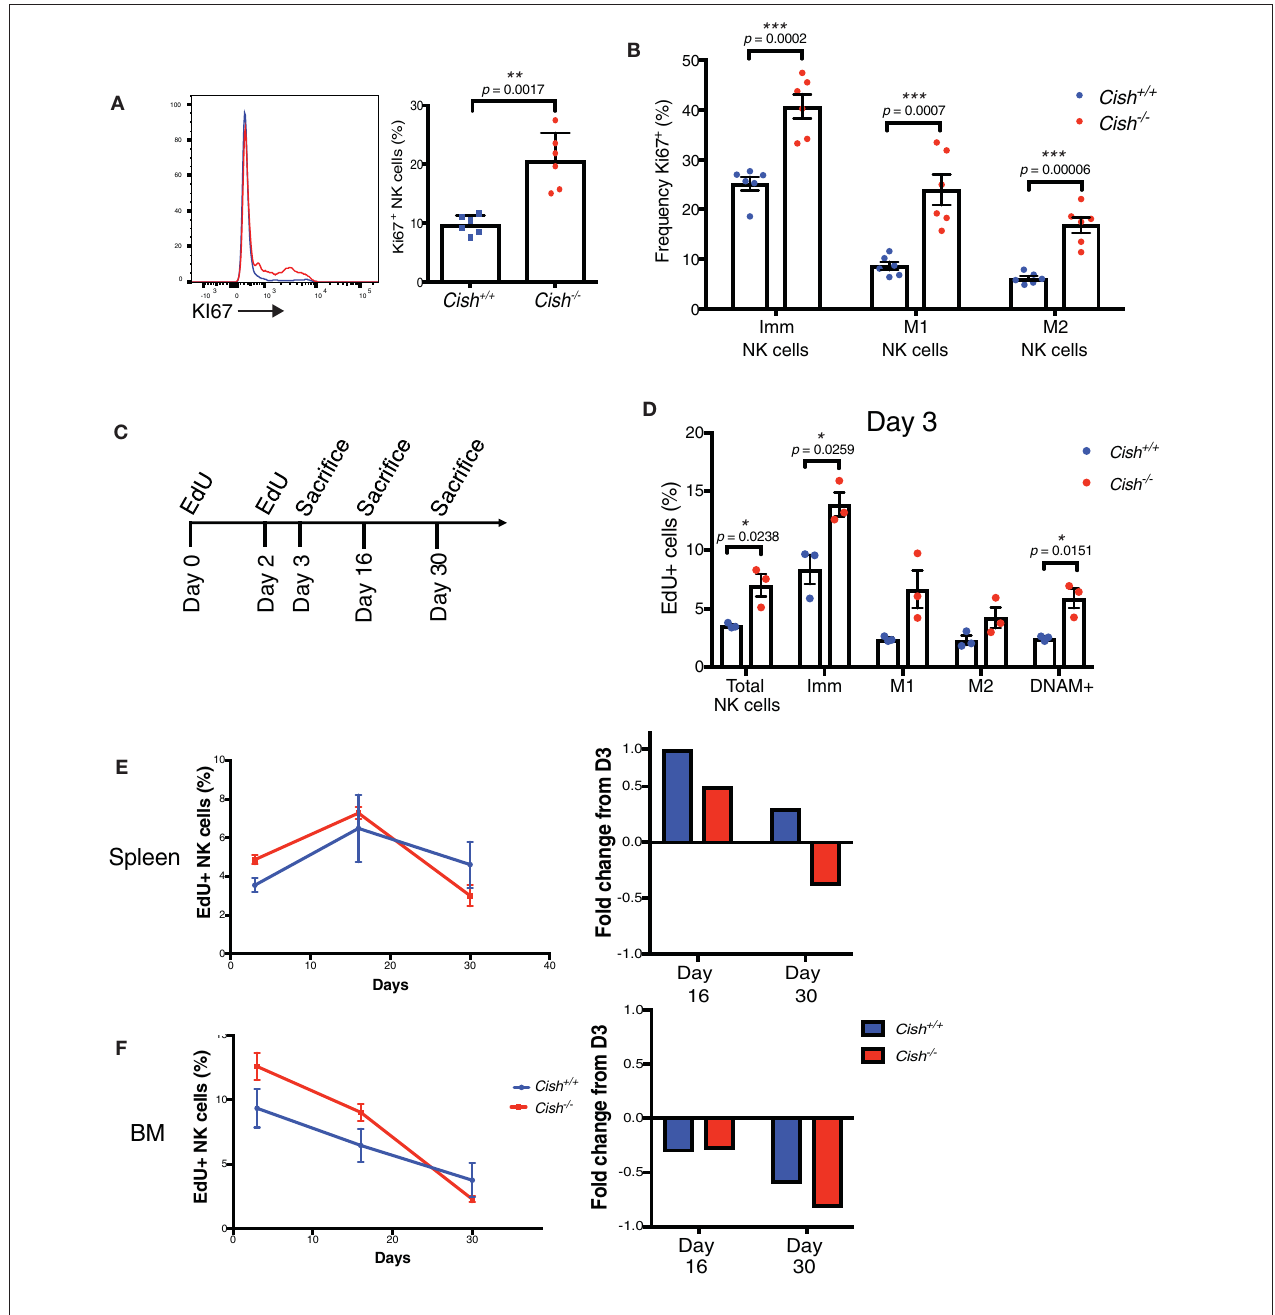
FIGURE 2 | CIS governs NK cell turnover but not accumulation in vivo. (A) Splenic NK cells from 6 to 8 week-old Cish + / + and Cish − / − mice were phenotypically analyzed by flow cytometry for Ki67 + expression; representative histograms ( A , left panel) and the percentage of Ki67 + NK cells ( A , right panel) ** p < 0.01 (unpaired Student’s t -test). (B) NK cell maturation subsets as shown in ( Figure 1B ) were analyzed for Ki67 expression *** p < 0.001 (unpaired Student’s t -test). (C–F) NK cell turnover was assessed in 6–8 week-old Cish + / + and Cish − / − mice using the ClickIT plus EdU staining Kit. (C) Schematic showing EdU administration schedule and end points. (D) Three days after initial injection, the EdU + proportion of total splenic NK cells and maturation subsets were analyzed and quantified by flow cytometric analysis * p < 0.05 (unpaired Student’s t -test). (E,F) The percentage of total dividing splenic NK cells and maturation subsets were measured in the spleen and BM (left panels) over time and quantified by flow cytometric analysis. Fold change of EdU uptake or loss over time was calculated using Day 3 as input data (right panels). ( A , B , n = 6 biological replicates mean ± s.e.m.; D–F , n = 3 biological replicates of one experiment representative of two independent experiments with similar results, mean ±